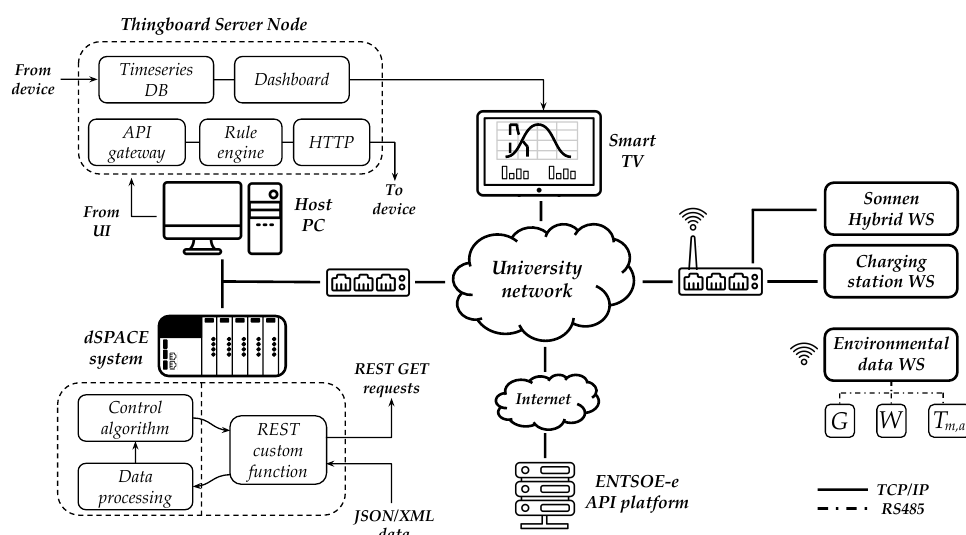
Figure 3. Communication network architecture for the proposed EMS and data visualization.